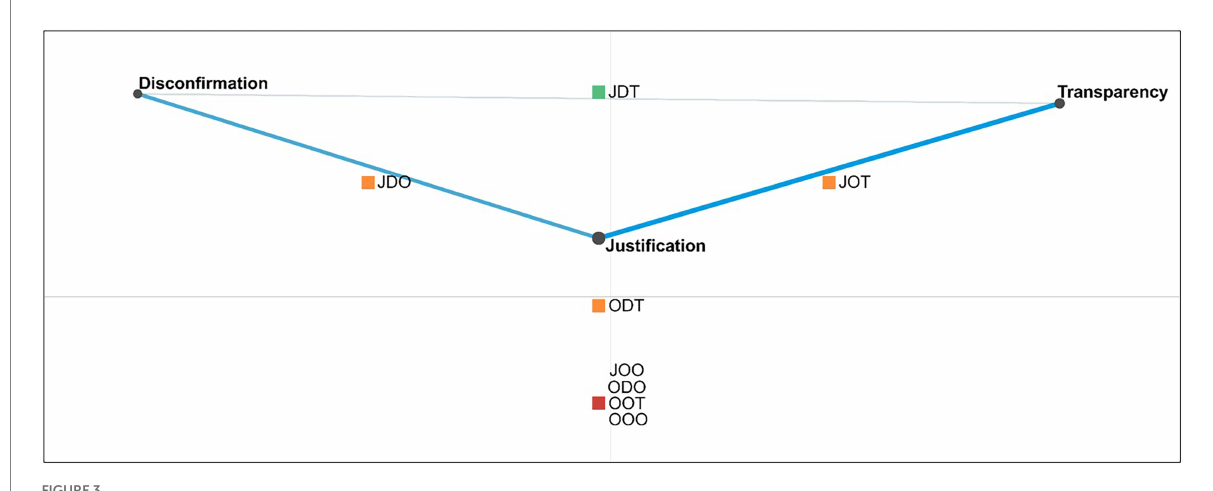
FIGURE 3 Argumentation types (indicated by colored squares) plotted in a two-dimensional space to indicate the relationship between the argumentation types and the individual facets (indicated by gray nodes) and the co-occurrences of the facets (indicated by blue lines). argumentation types are characterized by: J, Justification; D, Disconfirmation; T, Transparency; O, Absence of a Facet. For example: JOT, Justification and transparency without